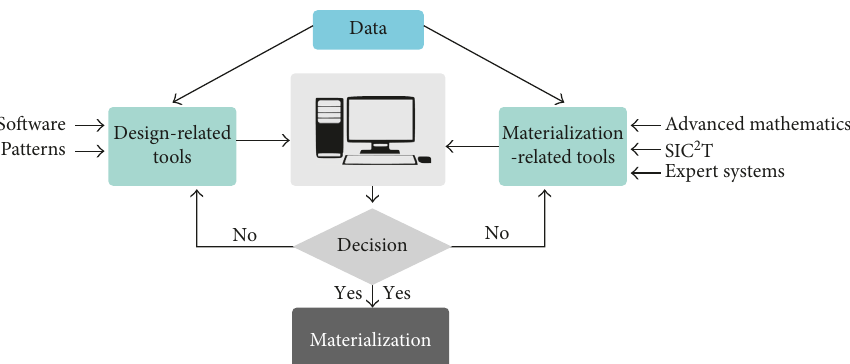
Figure 4: The scheme illustrates the workflow method. This model is built upon 4 hierarchical steps: (1) Data collection; (2) simulation analysis; (3) decision; (4)